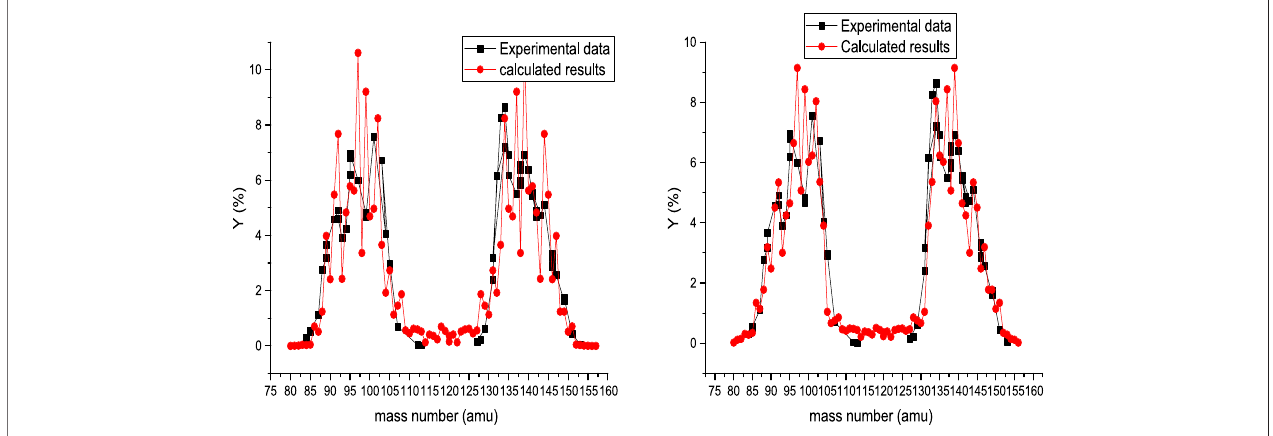
FIGURE 2 | Calculated mass yield for photo fi ssion of 238 U at 8 MeV bremsstrahlung endpoint energy, accompanied by experimental data [36]. In the left and right sides are presented the calculated results obtained for T coll (cid:1) 1 MeV and T coll (cid:1) 2 MeV, respectively.